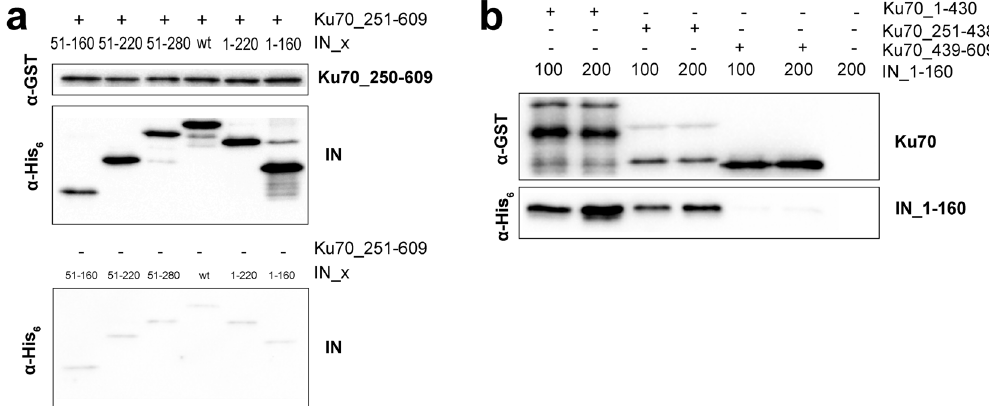
Figure 5. GST-pull down assay analysis of the binding between deletion mutants of Ku70 and IN. ( a ) Interaction between IN_wt and its deletion mutants (IN_1-220, IN_1-160, IN_51-280, IN_51-220, IN_51- 160) (200 nM) with Ku70_250-609 (100 nM). The direct load of the truncated proteins shown at Fig. 4c. ( b ). Interaction between IN_1-160 (100, 200 nM) and Ku70_1-430, Ku70_251-438 or Ku70_439-609 (100